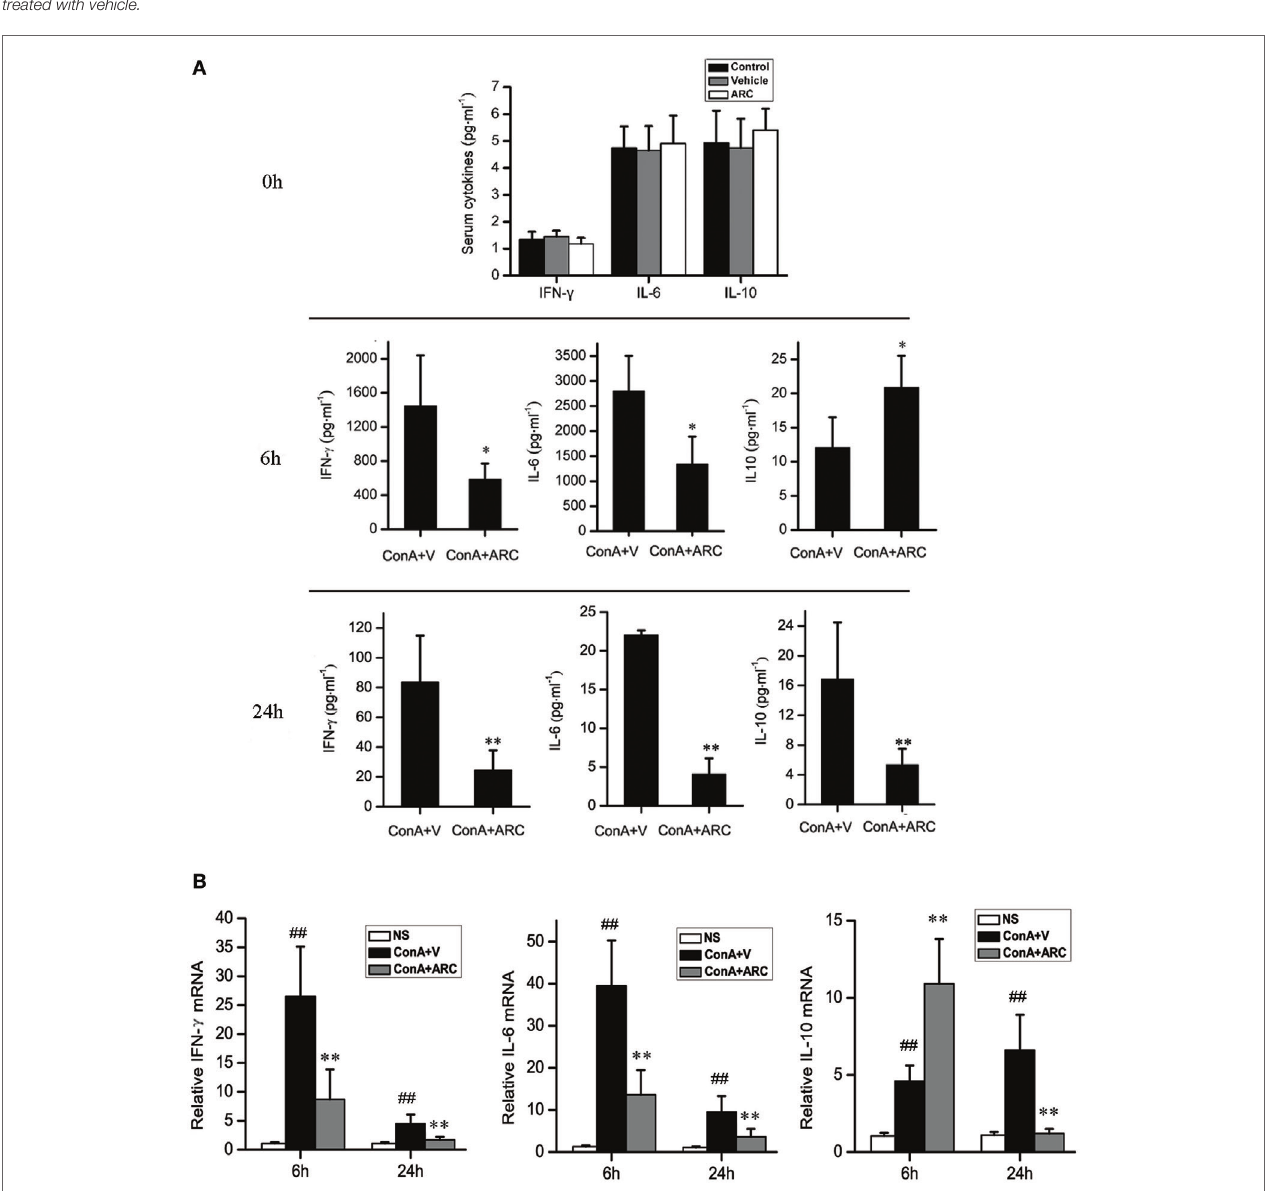
FigUre 6 | The influence of ARC on the cytokines in serum and liver tissues after ConA (10 mg ⋅ kg − 1 ) administration with and without ARC pretreatment. (a) The influence of ARC on the release of cytokines. In the presence of drugs or vehicle treatments twice per day for 10 days, ARC or vehicle alone had no effects on the inflammatory responses in normal mice. The levels of IL-6 and IFN- γ were decreased in serum in ARC pretreatment group at 6 and 24 h, and the level of IL-10 was still kept increasing from 6 to 24 h at model group, ARC pretreatment further increased the level of IL-10 at 6 h, but the level of IL-10 in ARC pretreatment mice was lower than that in model mice at 24 h. (B) The influence of ARC on the mRNA level of cytokines in liver tissues. The mRNA levels of IL-6 and IFN- γ in liver tissues were both increased after ConA administration. They were decreased by ARC pretreatment at 6 and 24 h. ARC pretreatment further increased the mRNA level of IL-10 in liver tissue at 6 h after ConA administration. At 24 h, the mRNA level of IL-10 was further increased in model group, but it returned to normal level in ARC pretreatment group. ## p < 0.01 compared with normal group; * p < 0.05, ** p < 0.01 compared with model group ( n = 8). The mice pre-treated with vehicle were used as model group.